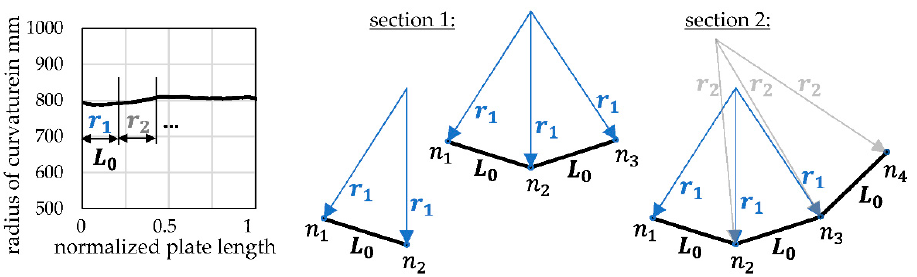
Figure 5. Principle of the geometric model of the plate.